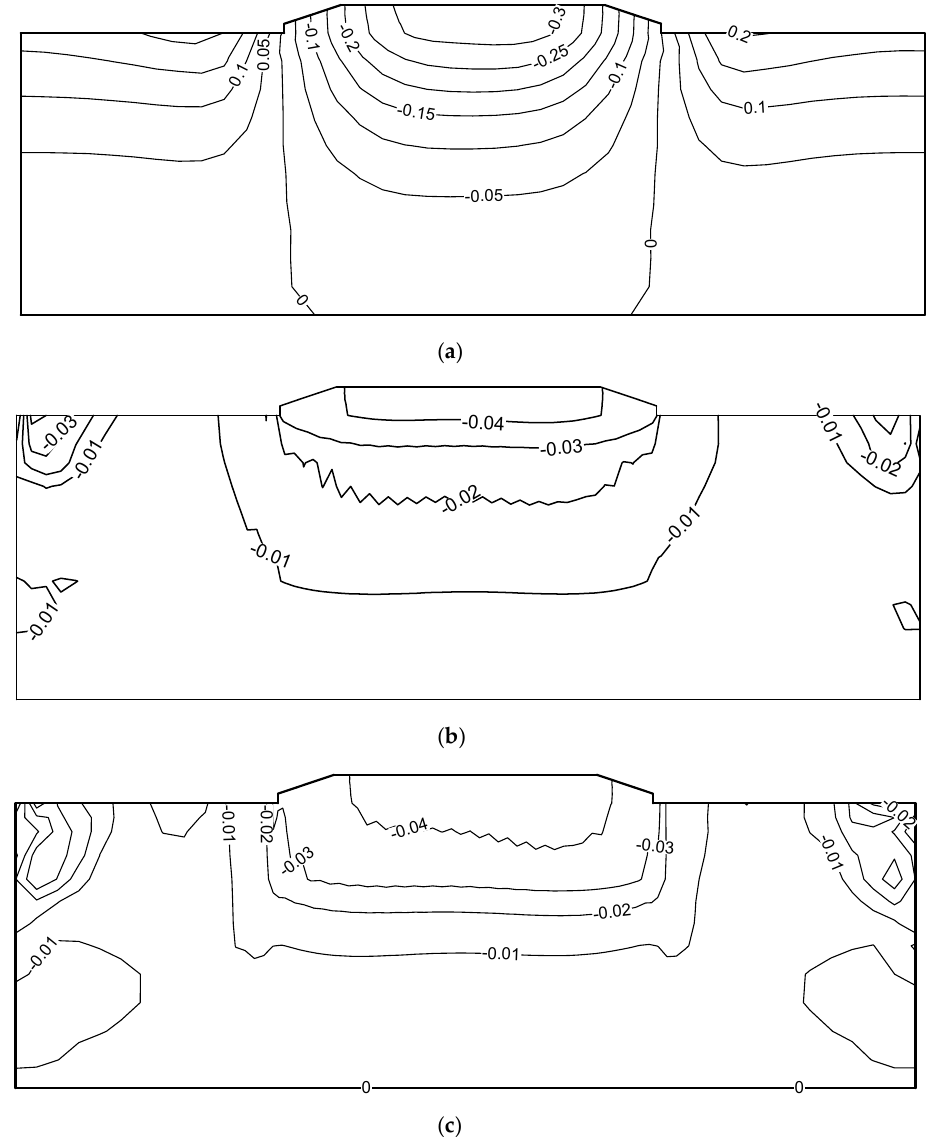
Figure 8. Contours of seismic subsidence of natural foundation and reinforced foundations. ( a ) Natural foundation. ( b ) Foundation reinforced with isometric gravel piles. ( c ) Foundation reinforced with subarea long-short gravel piles.